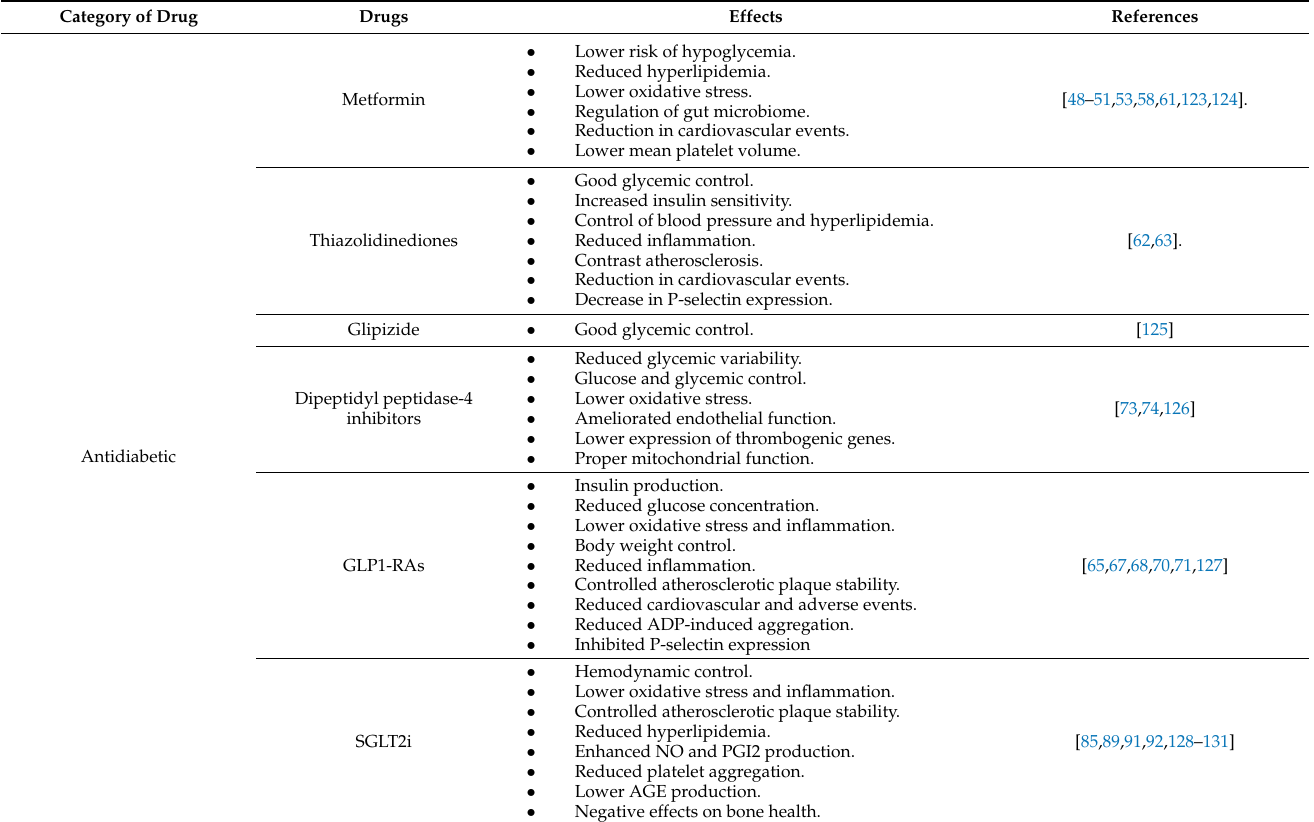
Table 1. Summary of the effects of antidiabetic drugs, anti-inflammatory drugs, P2Y12 inhibitors, and vitamin